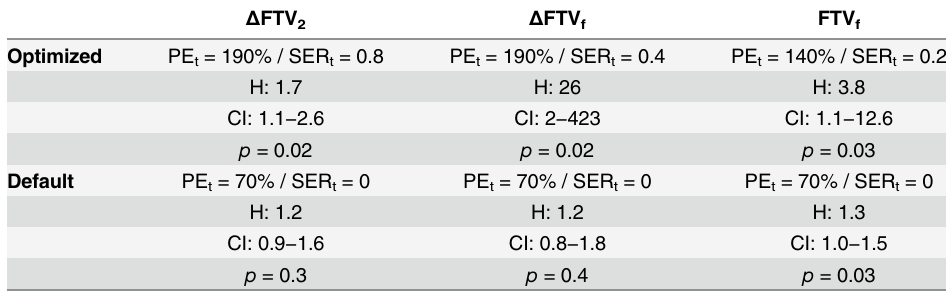
Table 4. Cox proportional hazards ratios at PE t /SER t with optimized association with RFS and at the default setting for patients with HER2+ breast cancer. Δ FTV Δ FTV 2 f FTV f Optimized PE t = 190% / SER t = 0.8